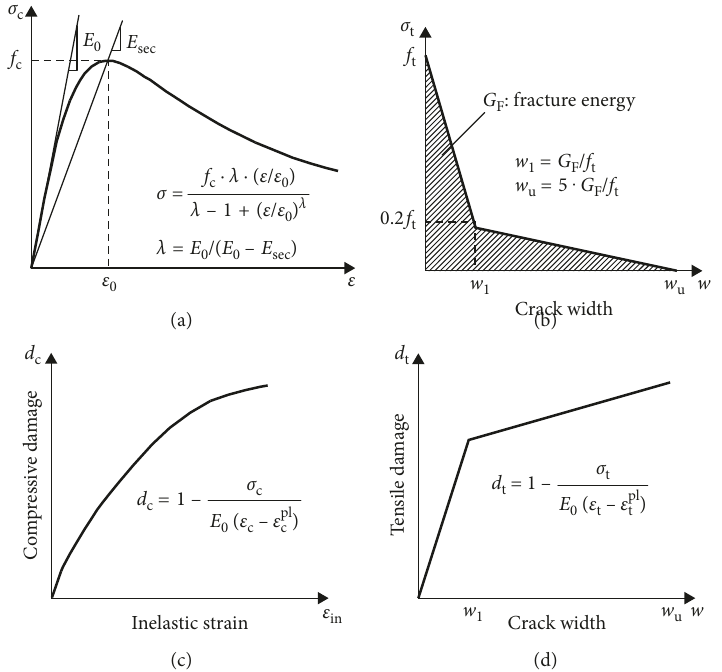
Figure 9: Constitutive laws of concrete: (a) compressive stress-strain curve, (b) tensile stress-crack width curve, (c) compressive damage- inelastic strain curve, and (d) tensile damage-crack width curve.